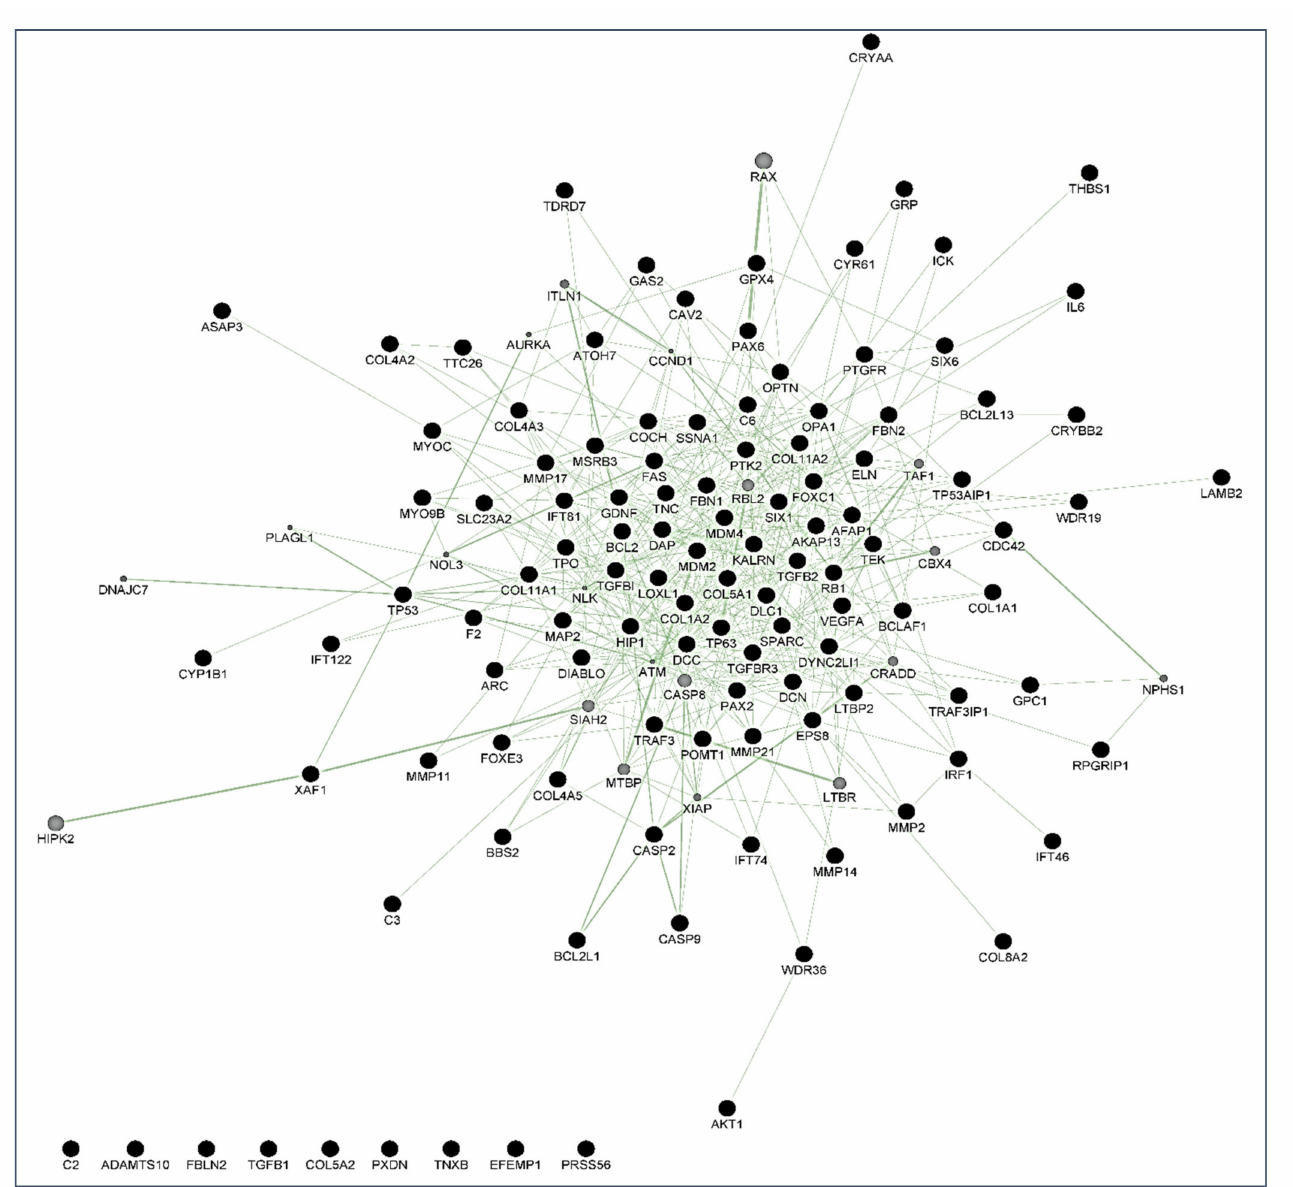
Figure 4. Genetic interaction map created with GeneMania. Black nodes are genes present in the original gene list, grey nodes are genes that are initially not present, but closely related to them. Among the genes, MYOC, OPTN, FOXC1, TGF β , FAS/TNFR, TP53, CASPs, BCL2, MMPs, and DIABLO were identified. Lines (edges) connecting two genes indicate that they are functionally associated (the effects of perturbing one gene are found to be modified by perturbations to the second gene) using data primary collected from BioGRID. Thicker edges indicate a stronger